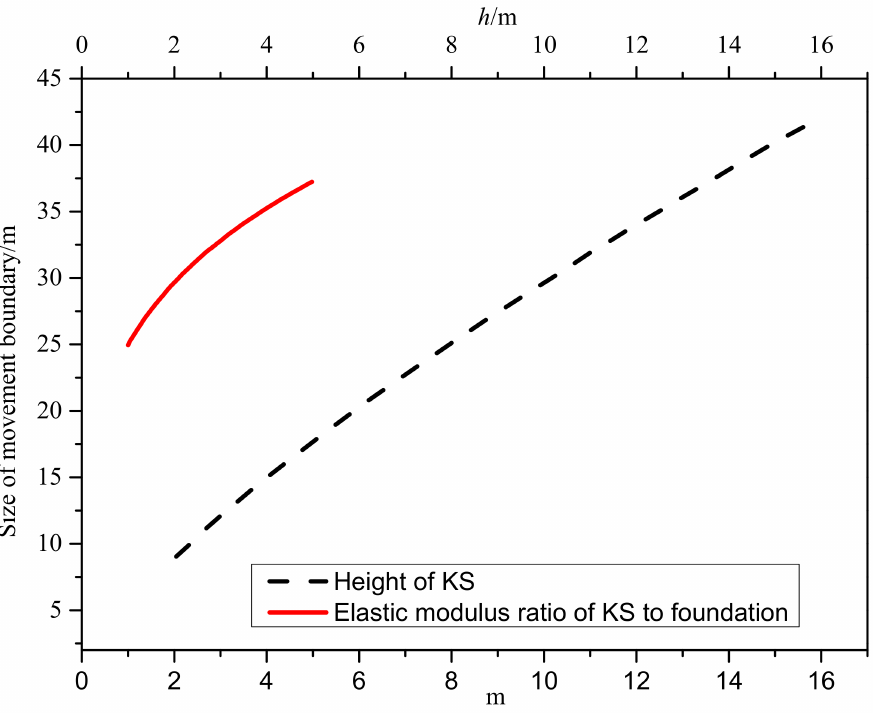
Figure 5. Relationship between the size of movement boundary and KS height and m